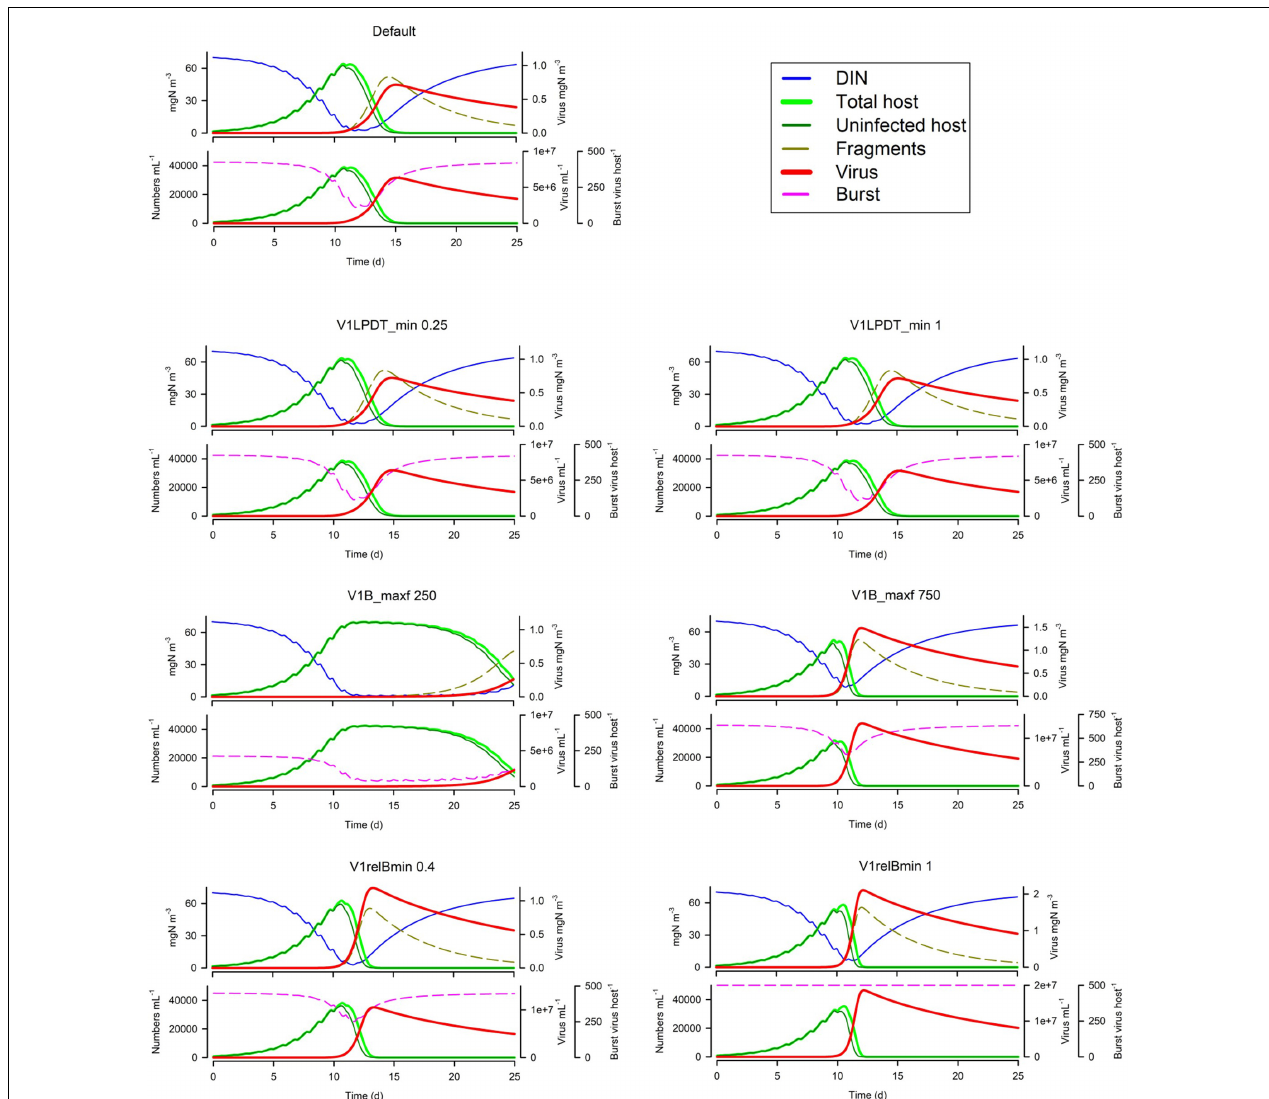
FIGURE 9 | Effects of the relationship between the minimum latent period and host doubling time ( V1LPDT_min 0.25 or 1 vs Default of 0.5), maximum burst size ( V1B_maxf 250 or 750 vs Default of 500 host − 1 ), and the relative minimum nutrient-compromised burst size ( V1relBmin 0.4 or 1 vs Default of 0.2). The Default ( Figure 1B ) is reproduced in the top left-hand corner. See also Table 5